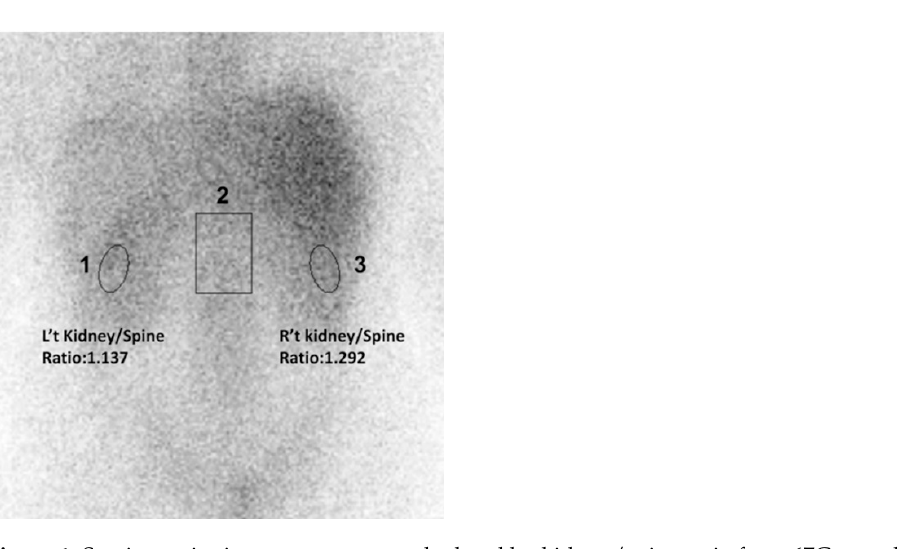
Table 1. Basic demographic data of 237 lupus nephritis patients by histological